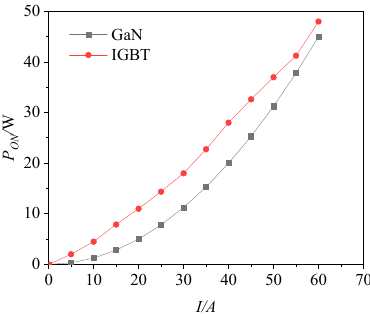
Figure 15. Relationship between forward conduction loss and current.